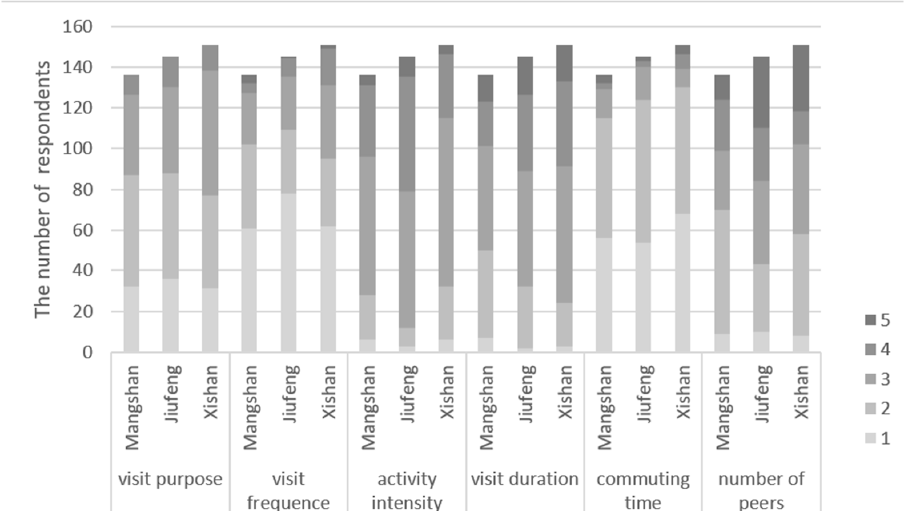
Figure 5. Visiting characteristics to forest park. For visit purpose: 1 = exercising, 2 = relaxing, 3 = being with families or friends, 4 = observing nature. For other visiting characteristics, “1” to “5” means “very few” to “very much” of visit frequency, and “very low” to “very high” of activity intensity, “less than one hour” to “more than four hours” of visit duration and commuting time, “zero” to “four or more” of number of companions.